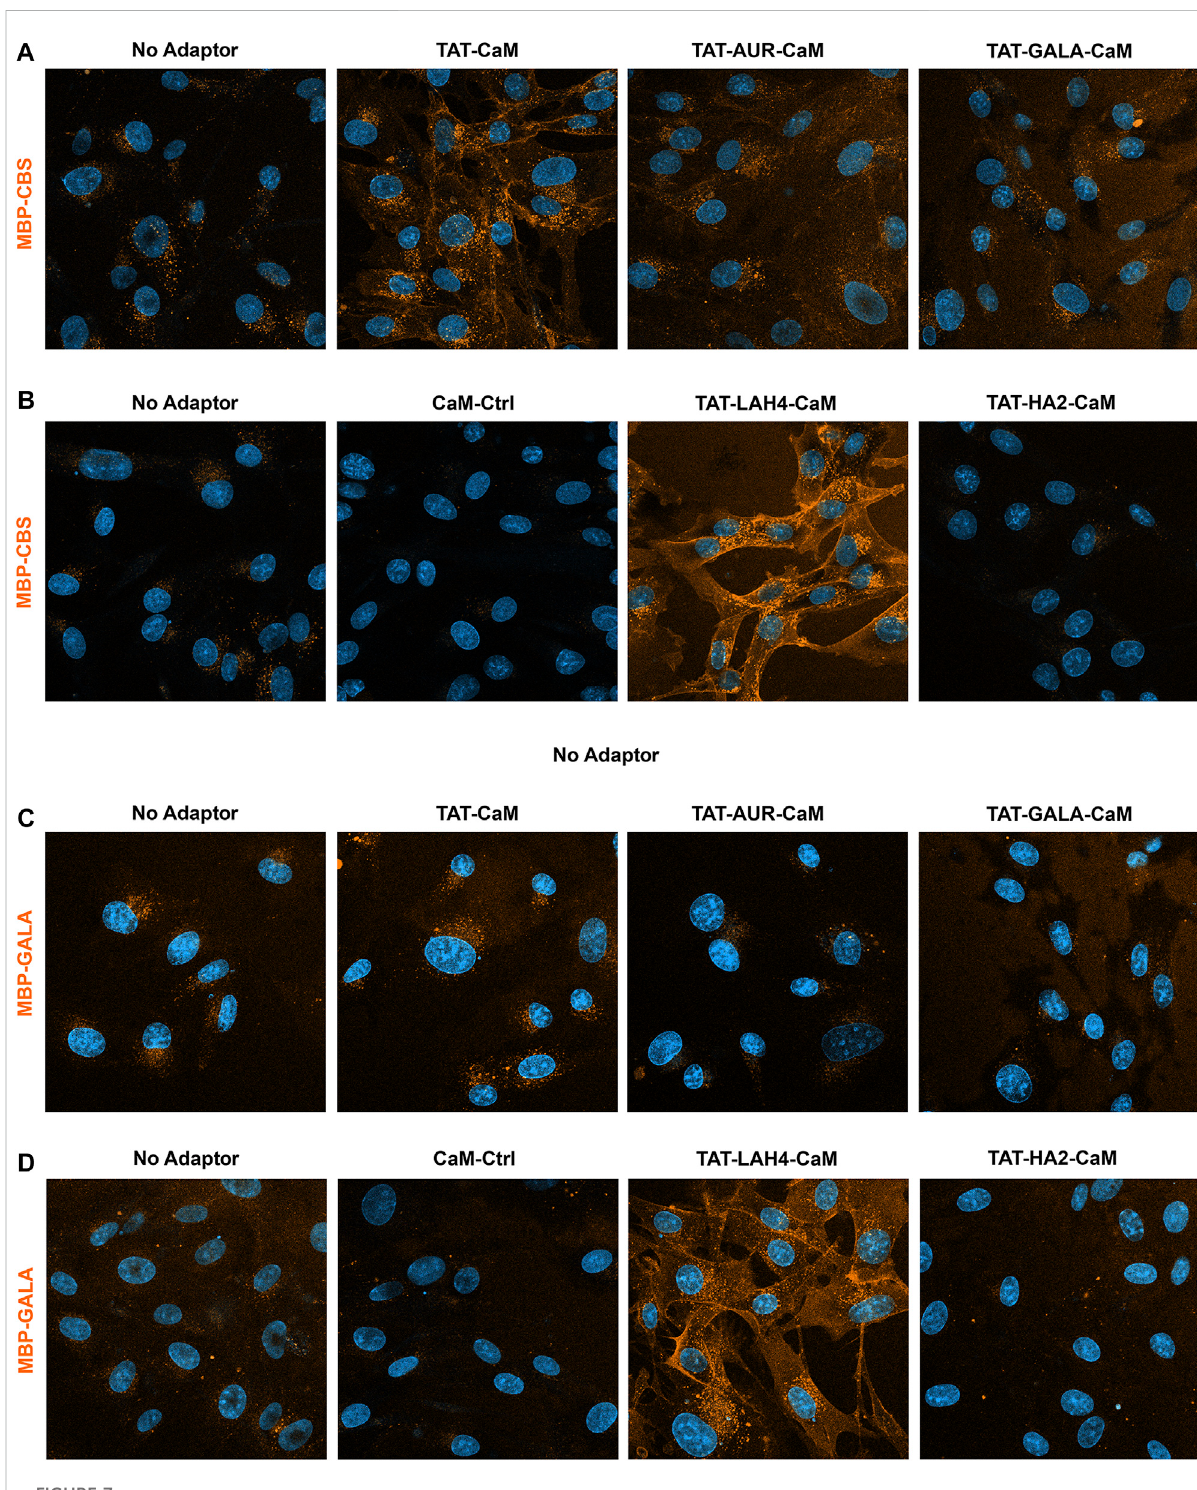
FIGURE 7 550- MBP-CBS and 550- MBP-GALA internalized with adaptor set including controls. Internalization of equimolar adaptor/cargo complexes (1 µM)ingrowthmediawereanalyzedassetsoffourconditions, eachcontainingthenoadaptorcargoasreference.Allcomplexeswereinternalized for1 hprior towashing(PBSx2)andimaginginmediacontainingNucBlue.InternalizationofCBS-MBP intheupperpanel (A) used: noadaptor, TAT- CaM, TAT-AUR-CaM, or TAT-GALA-C and in the lower panel (B) used: no adaptor, “ TAT-less ” CaM-Ctrl, TAT-LAH4-CaM, and TAT-HA2-CaM. Internalization of MBP-GALA used the same adaptor sets in the upper (C) and lower (D) panels. For presentation, intensities within each set were adjusted identically: however, for these cargos no-adaptor reference are not presented at equal intensity in upper and lower panels to avoid oversaturating internalization with